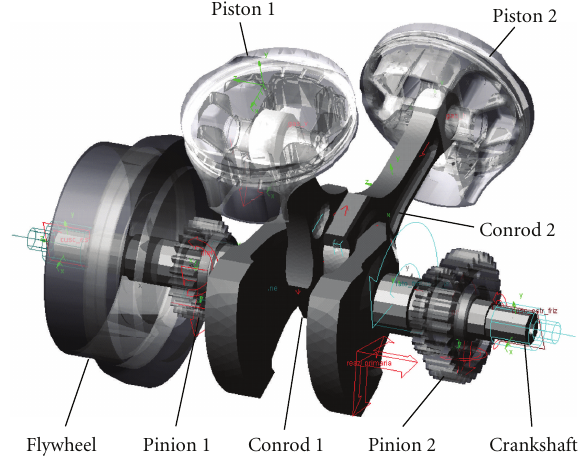
Figure 2: Multibody model of the cranktrain implemented in ADAMS.